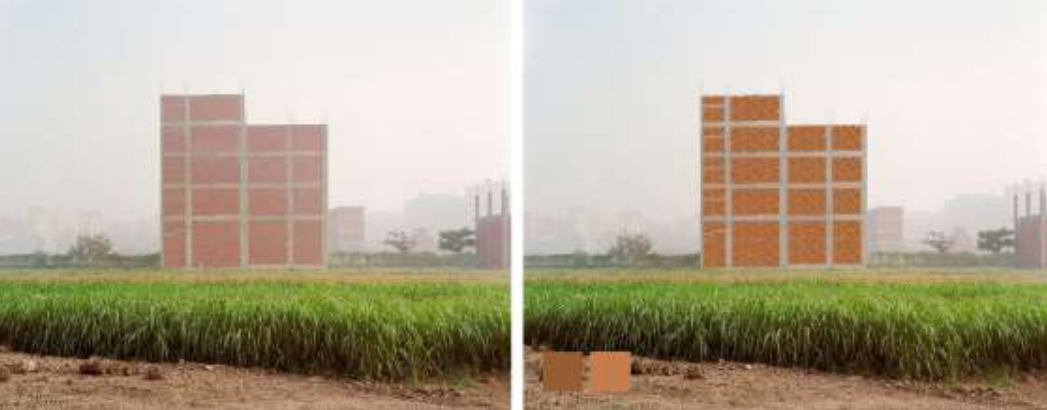
Figure 14 Concepts for tinted bricks